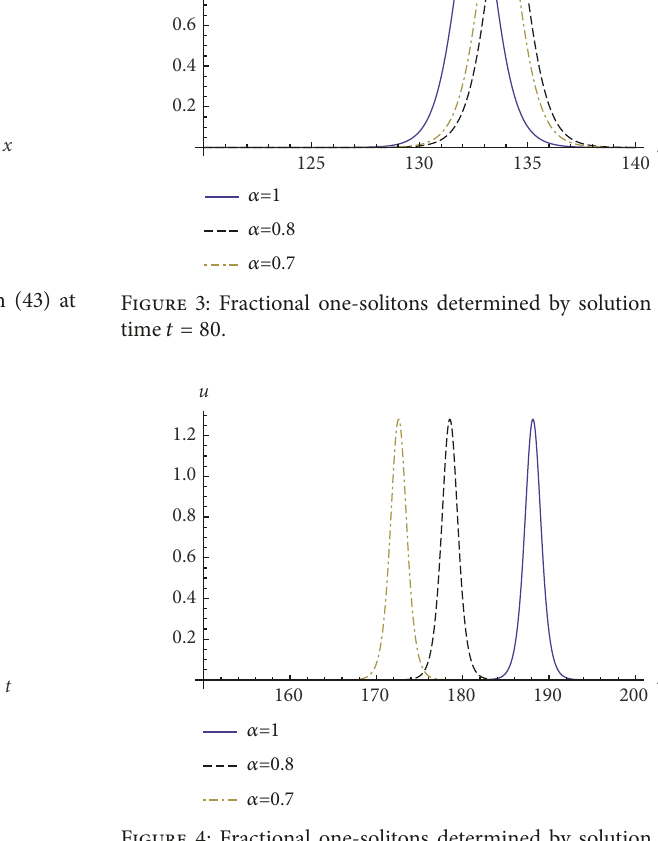
Figure 2: Velocity images of fractional one-solitons determined by solution (43).